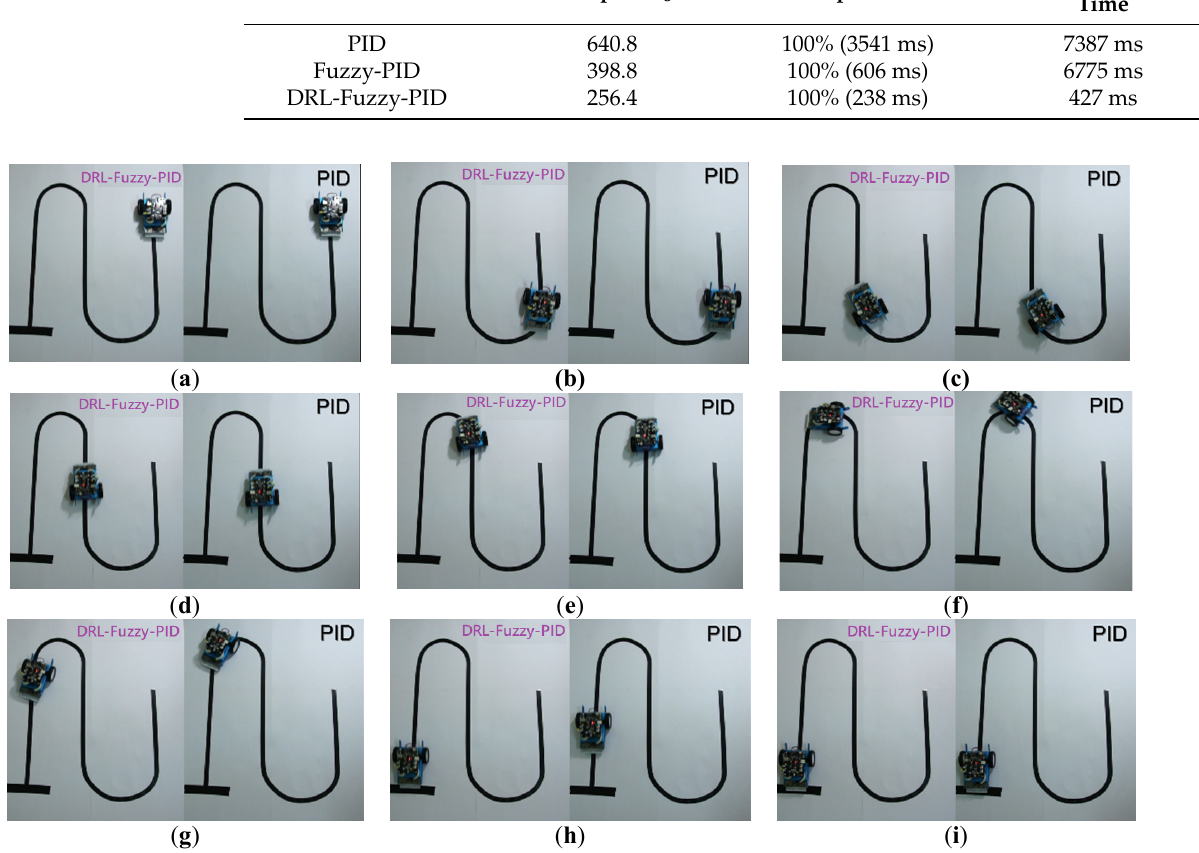
Figure 15. Comparison chart of the tracking position at each marker point. Mark ( a ): Start from the same point simultaneously. Mark ( b ): The radius of the first bend is approximately 11 cm. Data show that DRL-Fuzzy-PID tracks are closer to the line center than PID. Mark ( c ): Travel along a straight line after passing the first bend. Mark ( d ): Both are traveling along the center of the straight line. Mark ( e ): The radius of the second bend is approximately 8 cm. DRL-Fuzzy-PID provides a greater correction at the sharp bend due to the compensation of Δk p . Therefore, DRL-Fuzzy-PID can travel closer to the center than PID. Mark ( f ): DRL-Fuzzy-PID continues tracking along the line, while PID implements pseudocode B computing for reverting from deviation due to insufficient correc-